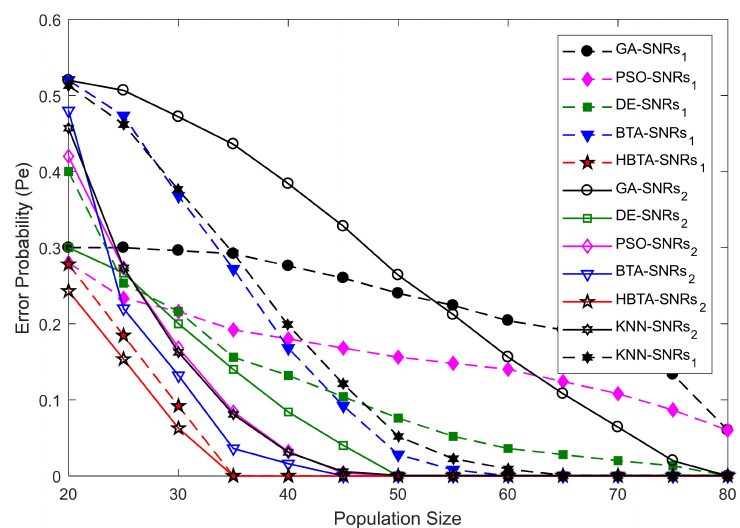
Figure 9. Error probability vs. population size in the presence of AO-AOC users with SNRs 1 ( − 9.5 dB) and SNRs 2 ( − 0.5 dB).